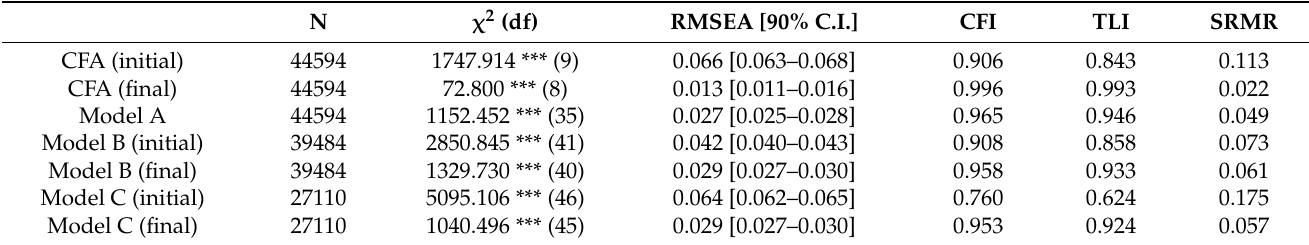
Table 2. Model fit